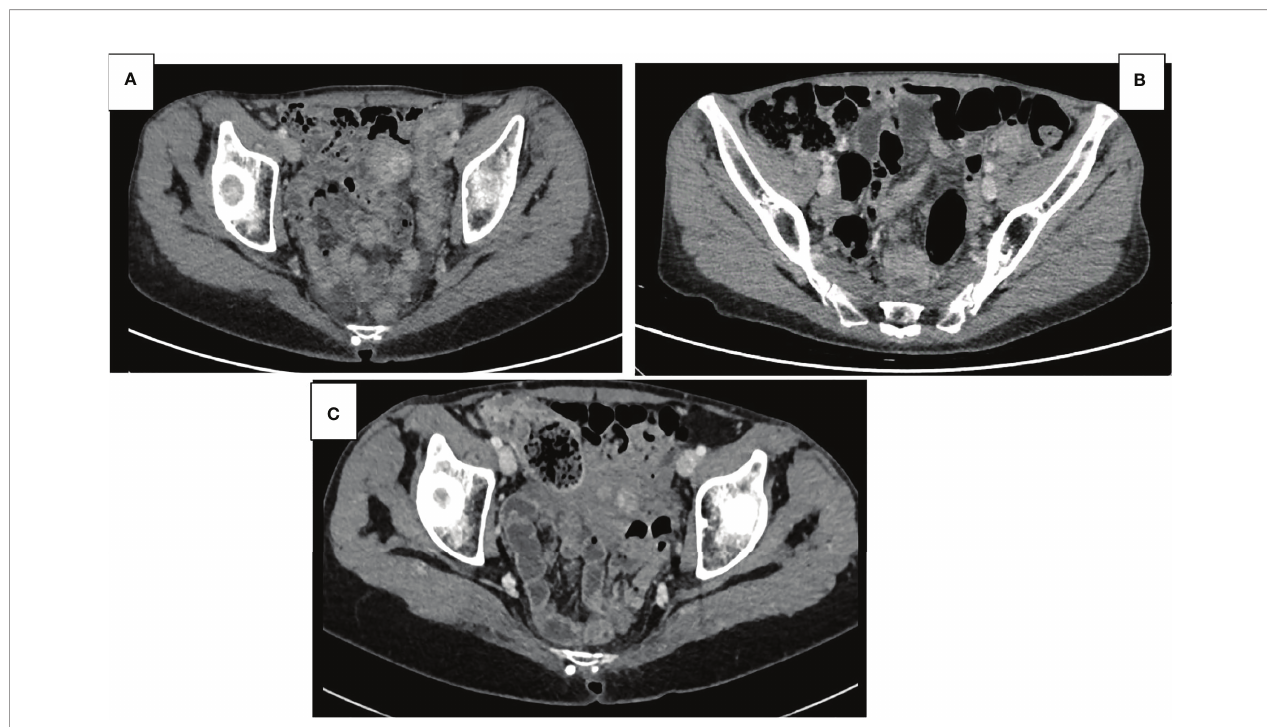
FIGURE 3 | Basal abdominal CT scans at the onset symptoms of pan-colitis with diffuse thickening of the colon walls (A) . Improvement of pan-colitis after 8 months of in fl iximab treatment and 9 months of Pembrolizumab discontinuation (B) . Persistent mild colitis after 24 months of Pembrolizumab discontinuation (C)